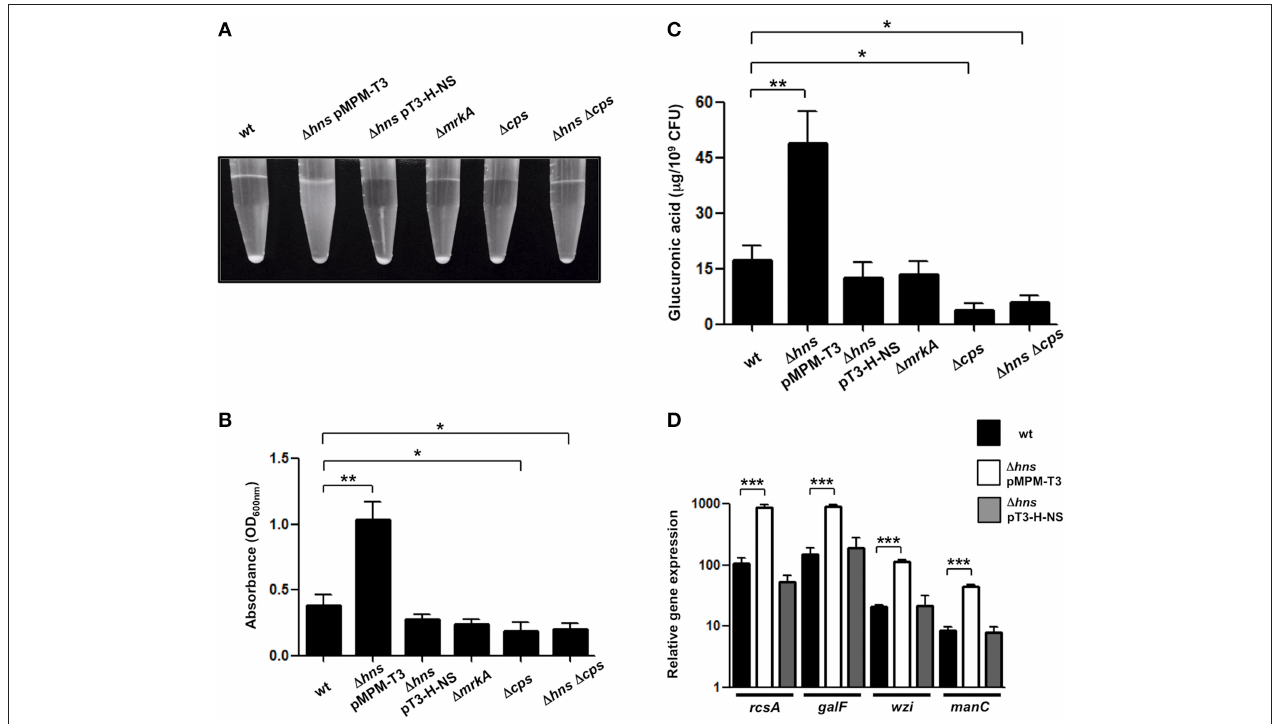
FIGURE 3 | H-NS represses capsular polysaccharide in K. pneumoniae . (A,B) Mucoviscosity of K. pneumoniae wild-type, 1 hns mutant, complemented 1 hns mutant, 1 mrkA mutant, 1 cps mutant, and 1 hns 1 cps mutant. The mucoviscosity was determined by low speed centrifugation and is expressed as OD 600 of the supernatant. (C) Capsule quantification of K. pneumoniae strains. The glucuronic acid concentration in each strain was determined from capsular polysaccharides extracted of 0.5ml bacterial cultures. (D) Transcriptional expression (qRT-PCR) of the rcsA, galF, wzi, and manC genes in the WT K . pneumoniae strain, 1 hns mutant and complemented 1 hns mutant. Data represent the mean of at least three independent experiments (mean ± SD). Statistically significant with respect to the wild-type strain *** p < 0.001 ; ** p < 0.01 ; * p < 0.05 .